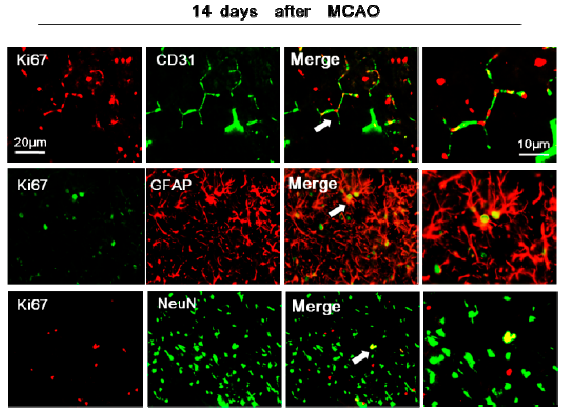
Figure 4. Expression of Ki67/CD31, Ki67/GFAP, and Ki67/NeuN -positive cells in the peri-infarct striatum at 14 days after MCAO. Double-immunofluorescence labeling for Ki67/NeuN, Ki67/GFAP, and Ki67/CD31 (white arrows indicate colocalized cells which are magnified in the right) in the peri-infarct striatum after MCAO. About 6% of NeuN-positive, 18.22% of CD31-positive, and 20.25% of GFAP-positive cells showed co-staining for Ki67 in the peri-infarct striatum of the control group. 2.6. rTMS Activates BDNF/TrkB Signaling Pathway in Ischemic Rats